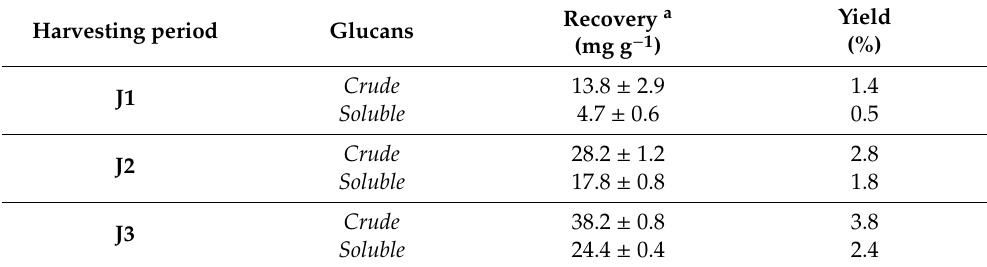
Table 2. Recovery of crude and soluble glucans from jujube fruits at three harvesting periods.